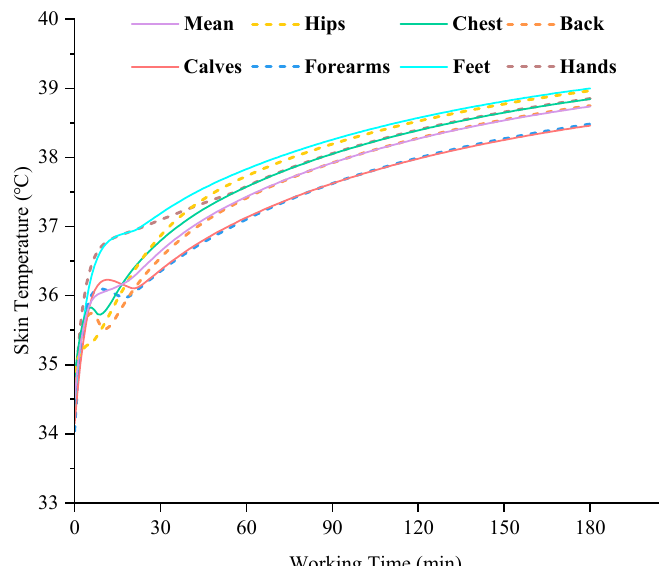
Figure 5. Changes in predicted skin temperatures of grid workers when working at a 37 °C and 55% RH environment.